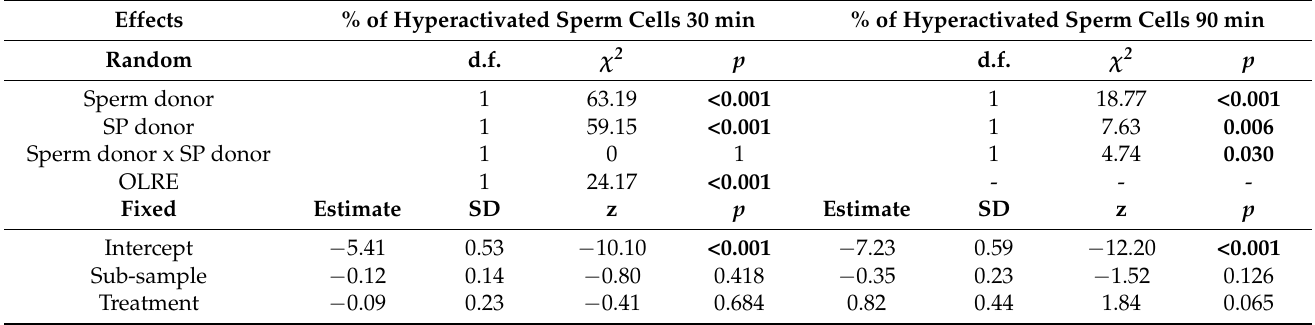
Table 2. Generalized linear mixed model (GLMM) statistics for the effect of sperm donor, SP donor, and their interaction (random effects) on the proportion of hyperactivated sperm cells at two time points (30 and 90 min) after the initiation of the SP treatment. Models also included fixed effects of sub-sample and treatment (own or foreign SP). OLRE = observation-level random effect.